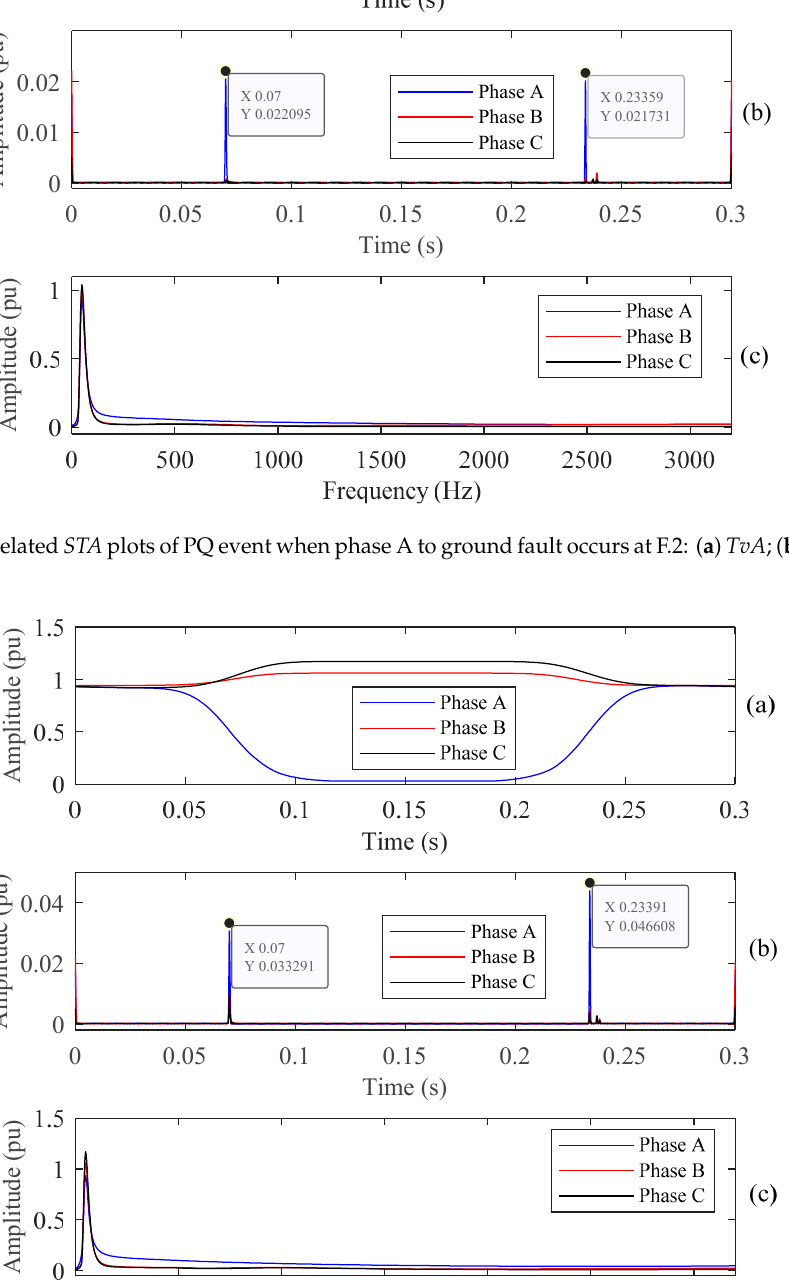
Figure 15. Related STA plots of PQ event when phase A to ground fault occurs at F.1: ( a ) TvA ; ( b ) TvHFA ; ( c ) FvA.